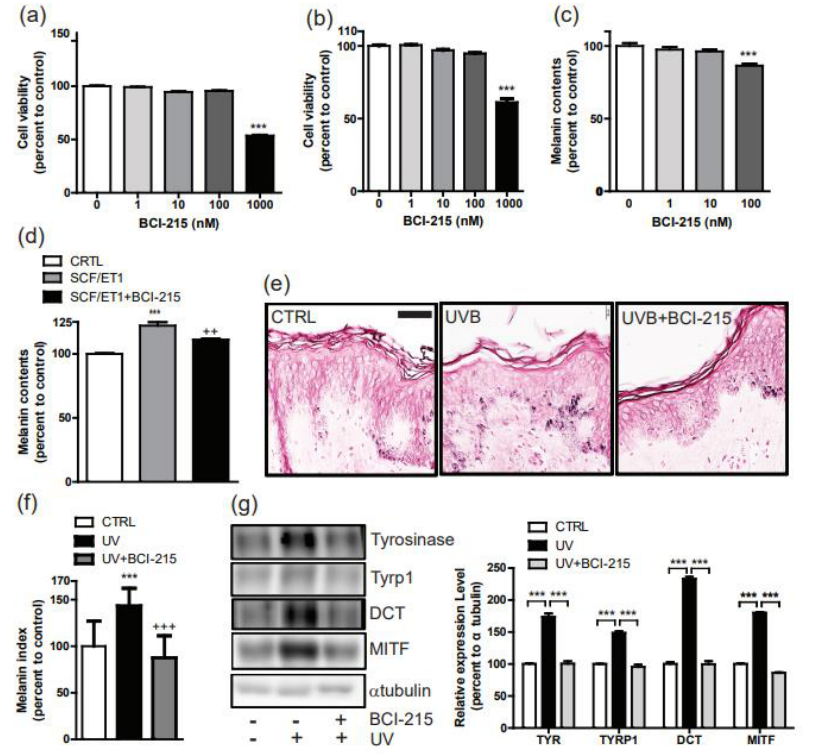
Figure 5. Effect of BCI-215 on melanogenesis in human keratinocyte-cocultured melanocytes and ex vivo human skin. Cellular viability was measured using a WST assay in ( a ) NHM and ( b ) NHK treated with 1 – 1000 nM of BCI-215 for 72 h. ( c ) The effect of a 100 nM dose of BCI-215 on the melanin content in NHM for the 72 h treatment. ( d ) The effect of BCI-215 on the melanin content in NHM cocultured with NHK stimulated by SCF and ET-1. ++ p < 0.01 vs. SCF and ET-1 treated NHM and NHK coculture. ( e ) Fontana – Masson staining of ex vivo human cultured skin tissue treated with a 200 mJ/cm 2 dose of UVB with or without the BCI-215 treatment. ( f ) The fraction of the area showing positive Fontana – Masson staining was calculated to determine the melanin index. +++ p < 0.001 vs. UV treated ex vivo skin tissue. ( g ) Immunoblotting ( n = 5) of the ex vivo human cultured skin tissue treated with UVB with or without a BCI-215 treatment with MITF, Tyrp1, tyrosinase, and DCT an- tibodies. Quantitative data in the right panel. – means vehicle treated control. ** p < 0.01, *** p < 0.001 vs. controls. 3. Discussion For the treatment of hyperpigmentary disorders, a variety of whitening agents have been investigated and developed to date. Among them, hydroquinone and kojic acid are still widely used as skin bleaching topical agents because they act as tyrosine inhibitors; there are few other effective alternatives. However, hydroquinone cream can cause unde- sired hypopigmentation and also shows cytotoxic effects at high concentrations [16]. Fur- thermore, kojic acid and its derivatives may be unstable in cosmetic formulations or at high temperatures, occasionally causing contact dermatitis or even paradoxical pigmen- tation [17,18]. Other treatment options for hyperpigmentation such as antioxidants, laser treatments, retinoids, and chemical peeling are not suitable for general applications due to their limited effects and high costs [19,20]. Hence, efforts to discover effective, but safe,